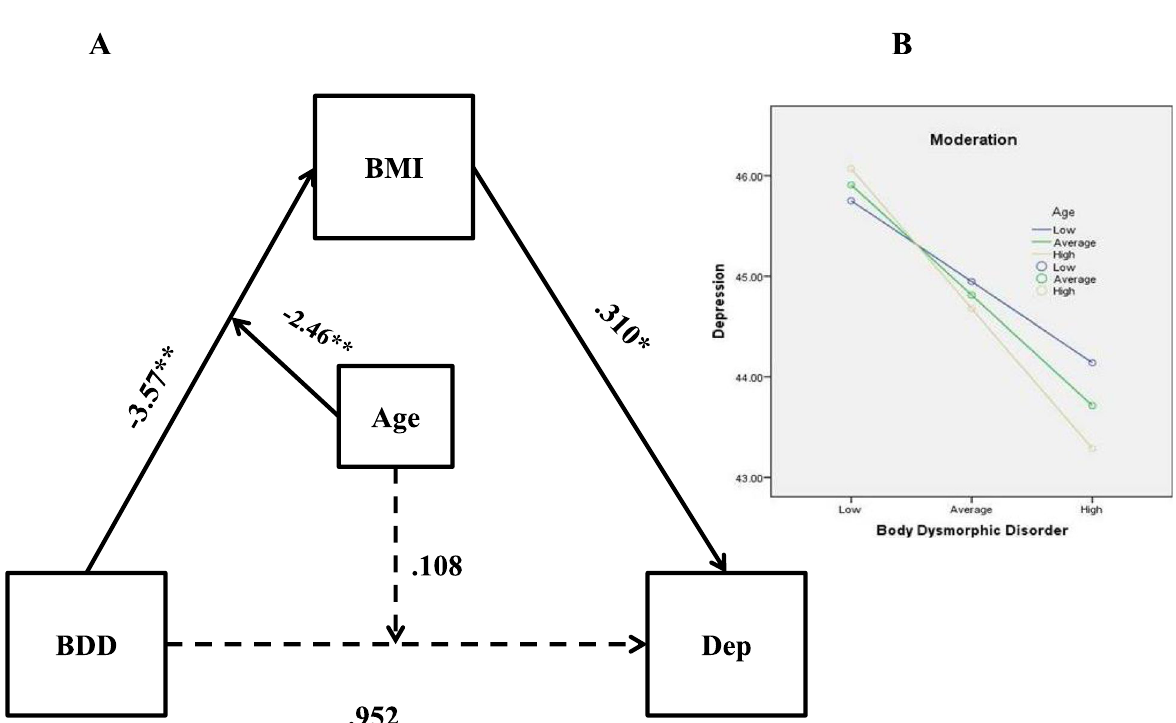
Fig. 4 A The proposed moderated mediation model is the association between body dysmorphic disorder and depression, mediated by BMI and moderated by age. The dashed arrows indicate non-significant effect, solid arrows indicate significant effect(s), and the numbers in the parentheses indicate effect from BDD to depression after controlling the effect of a mediator. B The moderation effect of age on the relationship between BDD and BMI. Simple slopes of the